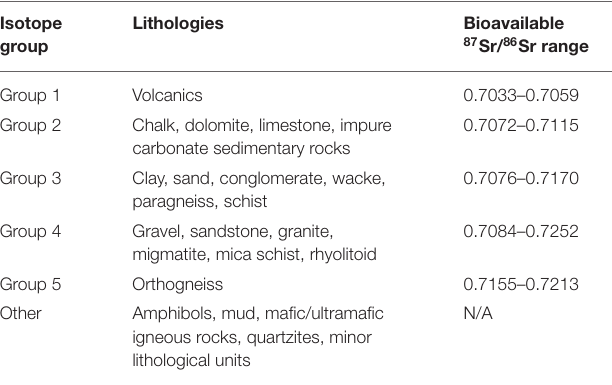
TABLE 1 | Isotope groups with their corresponding lithologies and bioavailable 87 Sr/ 86 Sr range (adapted from Willmes et al.,